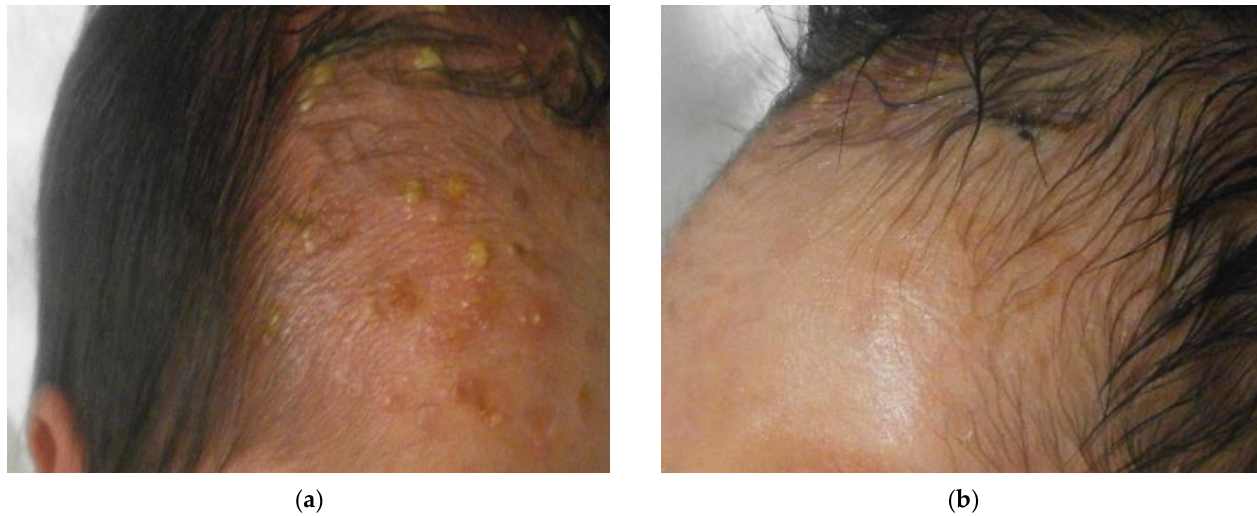
Figure 4. ( a ) New pustules continued to appear on the right forehead after topical ketoconazole treatment. ( b ) The pustules and erythema disappeared on the left forehead after topical corticosteroid treatment.